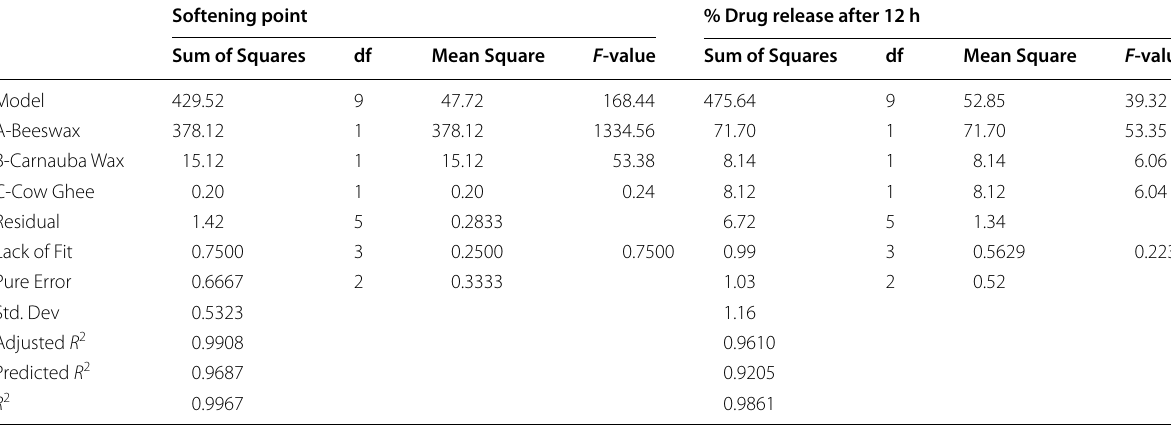
Table 5 ANOVA of the fitted equation for softening point and percentage release after 12 h from lipstick formulation Softening point Sum of Squares